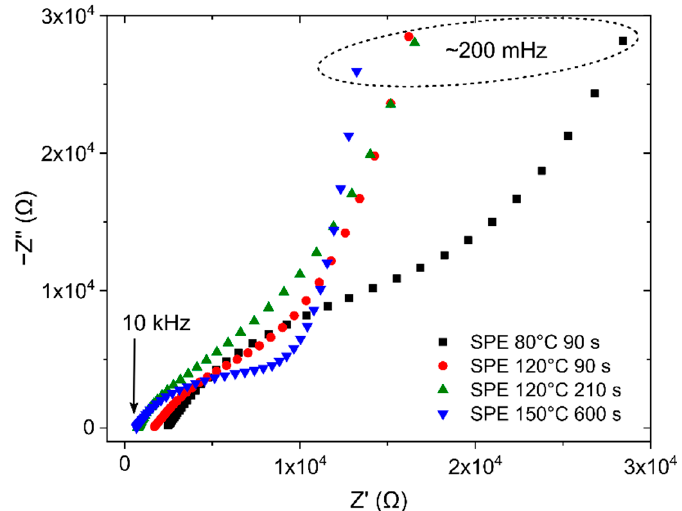
Figure 6. Nyquist plot for NO 2 sensors with different SPE types for 0 ppm NO 2 . Experimental results show that the SPE type has an impact on the position and shape of the first depressed arc, which should be represented by the SPE resistance and geomet- rical capacitance of the sensor itself. The shift of the spectra to the left, i.e., the decrease of NO 2